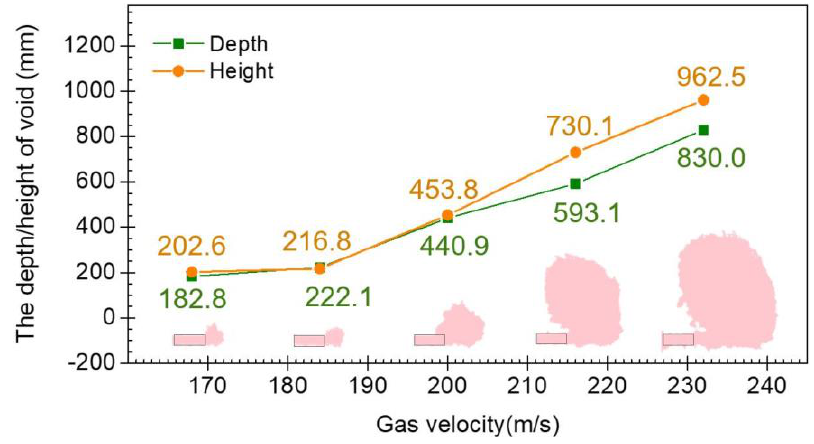
Figure 6. Void size and shape formed at different gas velocities, determined using the probabilistic method.